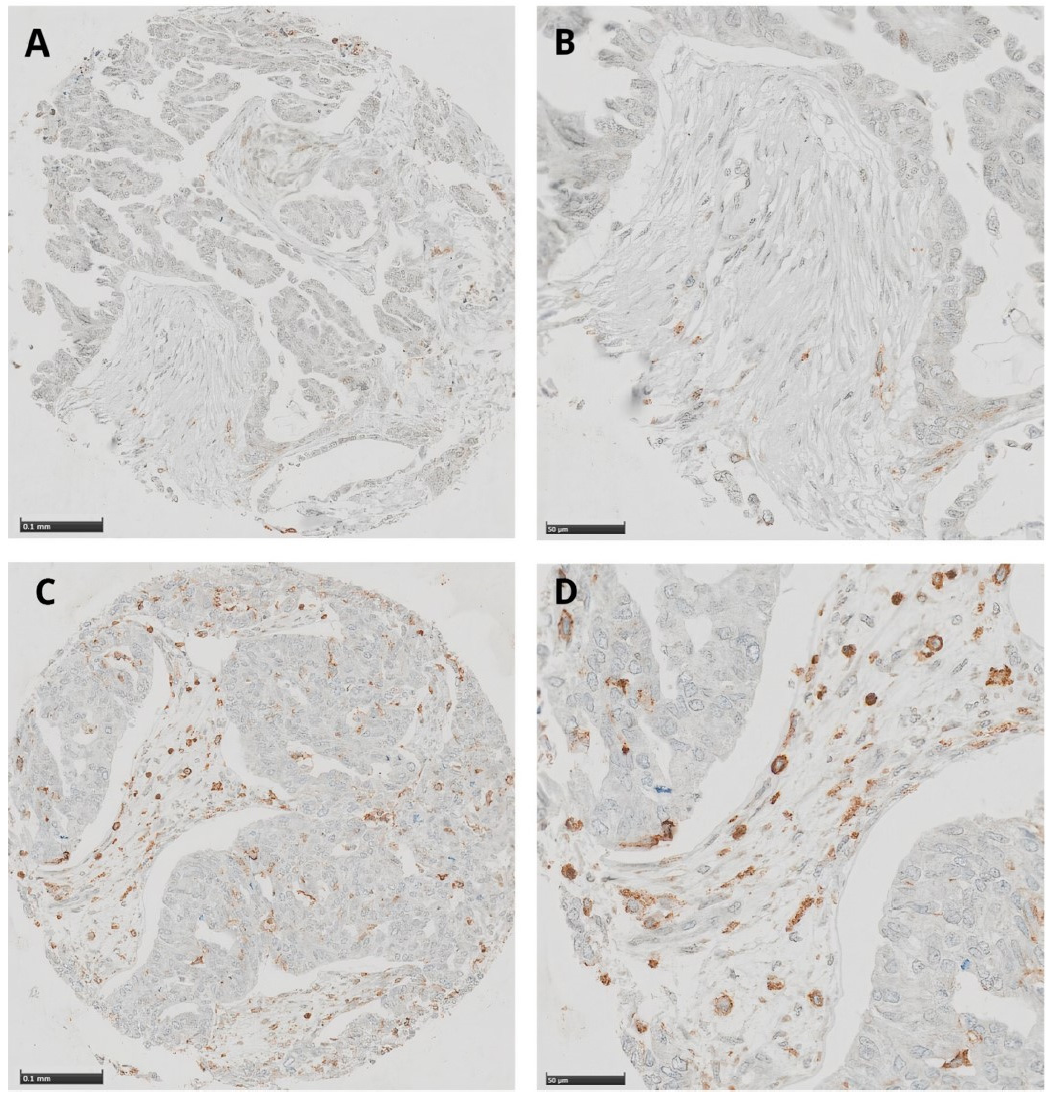
Figure 1. ( A , B ) Images demonstrate a high CD16 expression in TICs, whereas ( C , D ) images show only low to moderate CD16 expression in TICs. TICs: tumor-infiltrating cells.